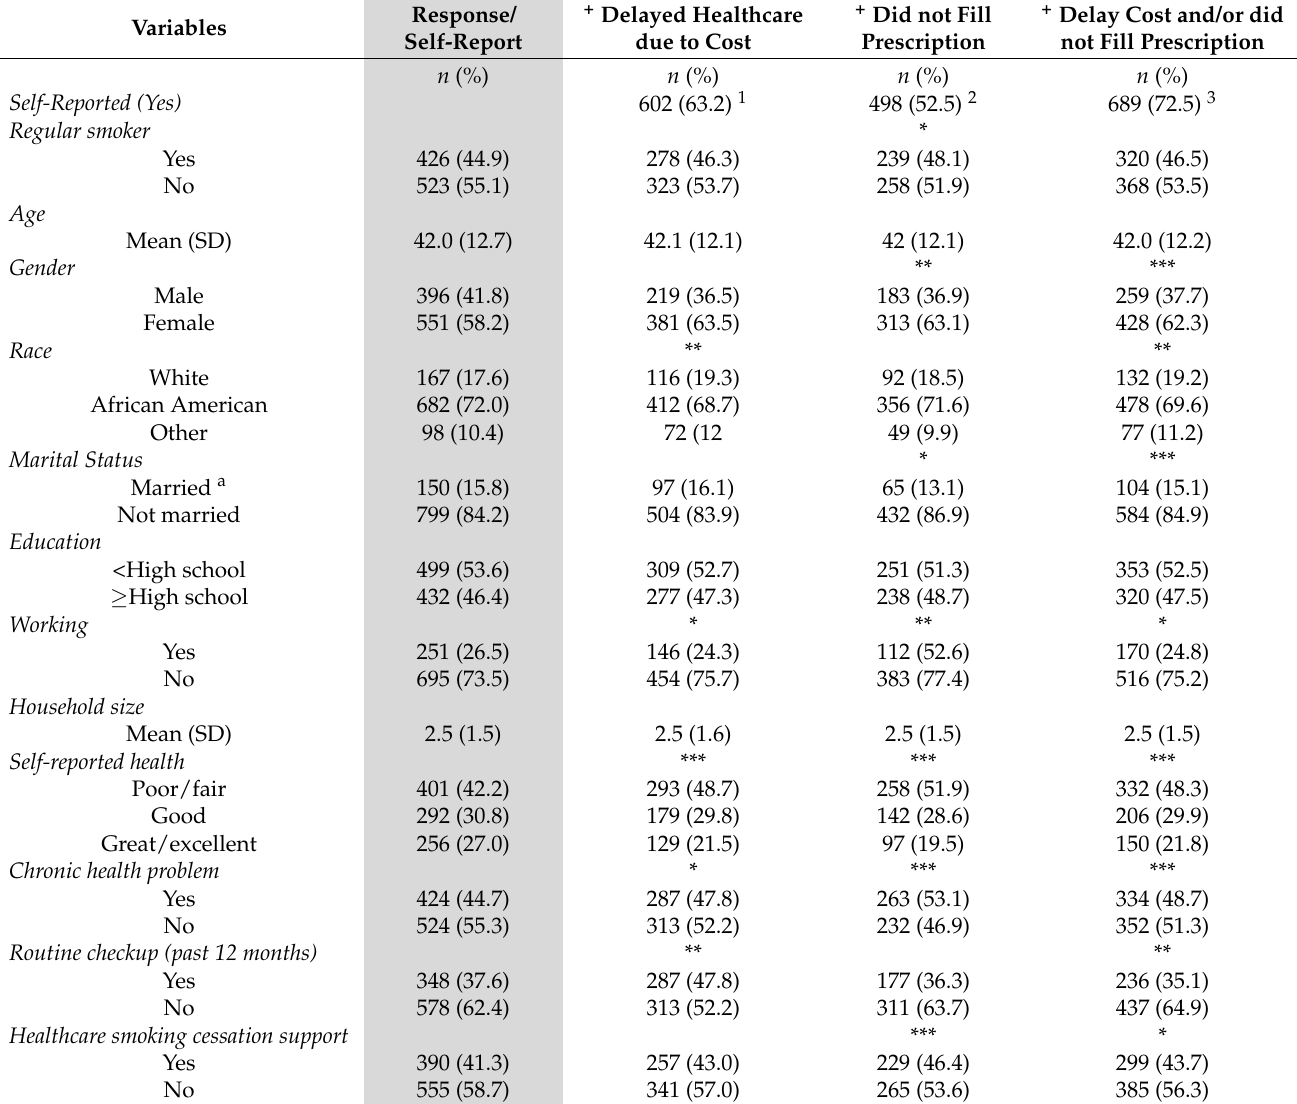
Table 1. Descriptive statistics of the study sample ( n =